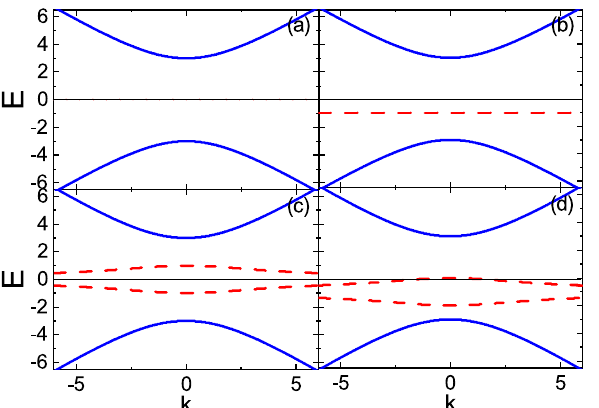
0 and Ŵ 1 0 , (b) Ŵ 0 Figure 2. (Color online) Dispersion relation of the system surface states for (a) Ŵ 0 z = = = 0 and Ŵ 1 and Ŵ 3 . The solid and dashed lines indicate 0 (c) Ŵ 0 1 , and (d) Ŵ 0 1 , with M and Ŵ z z = z = = = = = the real and imaginary parts of spectra, respectively. The bandgap width is 2 M